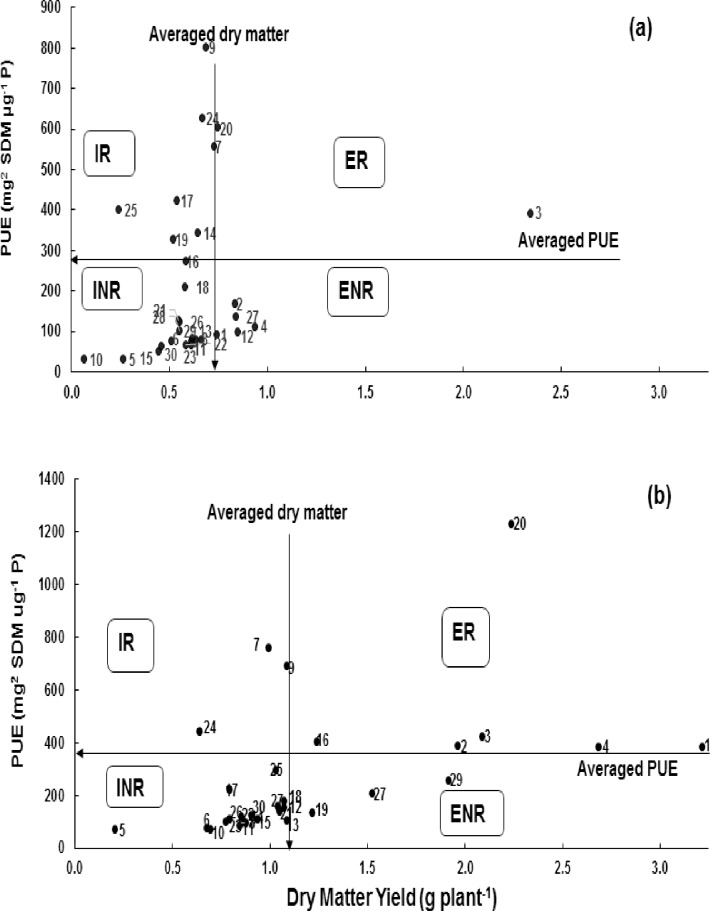
Classification of wheat genotypes at vegetative growth stage (in hydroponic) for P utilization efficiency a) at deficit P and b) at adequate P supply. Data are the mean value of four replicates. This categorization divides genotypes into four categories i.e. efficient and responsive (ER), in-efficient and responsive (IR), efficient and non-responsive (ENR), and in-efficient and non-responsive (INR) [28, 29].